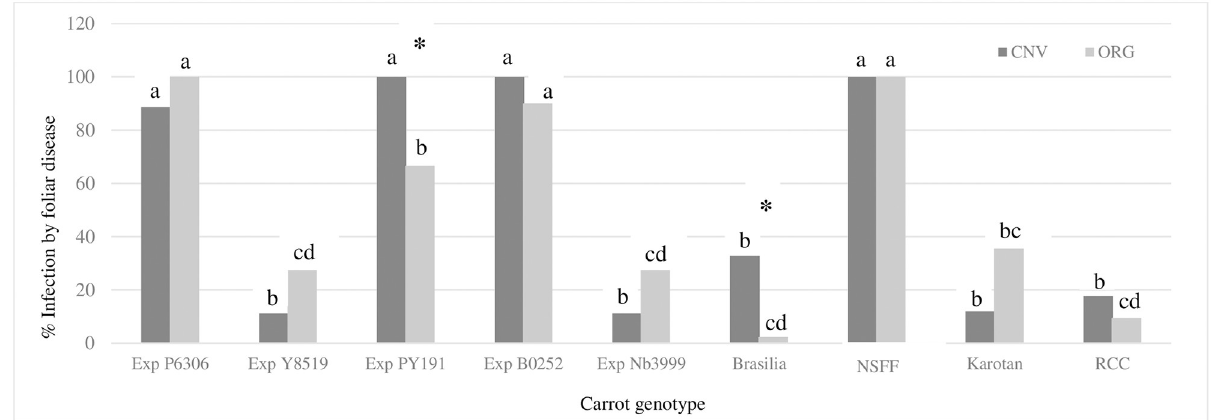
Fig 1. Percentage of carrot aboveground foliage displaying leaf blight disease symptoms including Alternaria in ten diverse carrot genotypes grown under organic and conventional management at Purdue’s Meigs Farm during summer 2014. Letters indicate significant differences between genotypes within each management system, and a star represents differences in management system within individual genotypes ( P < 0.001).